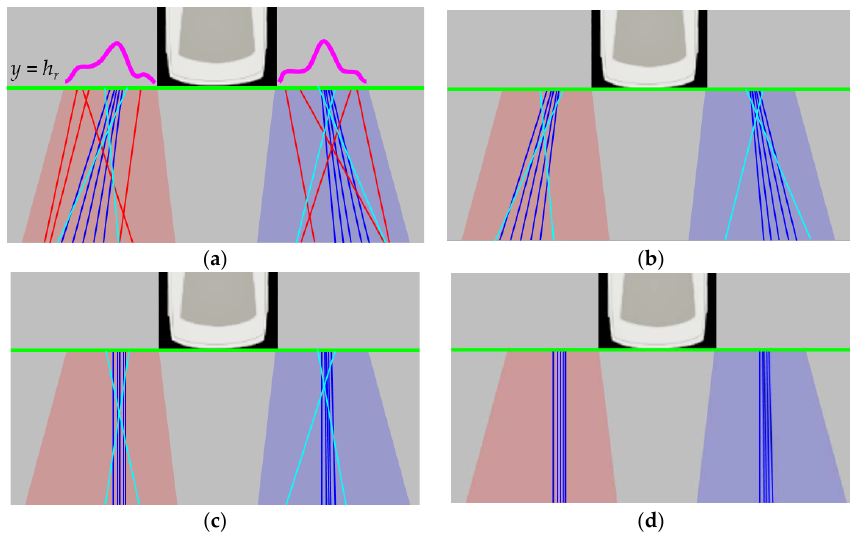
Figure 7. Outlier rejection based on the lane marking position and orientation. ( a ) Two positional histograms (magenta lines); ( b ) Position-based outlier rejection result; ( c ) Lane markings transformed by the vanishing point-based homography; ( d ) Orientation-based outlier rejection result.